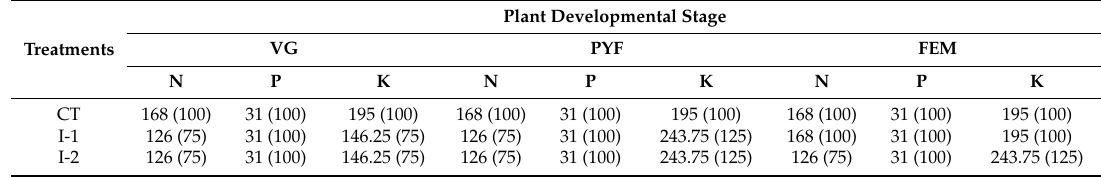
Table 1. Nutrient solution formulations of the three di ff erent treatments for the three developmental stages, including vegetative growth (VG), pollinated young fruit (PYF), and fruit enlargement and maturation (FEM) of hydroponic netted melon in Experiment I during summer–autumn 2018. Nitrogen (N), phosphorus (P), and potassium (K) concentrations (percent) in mg / L.